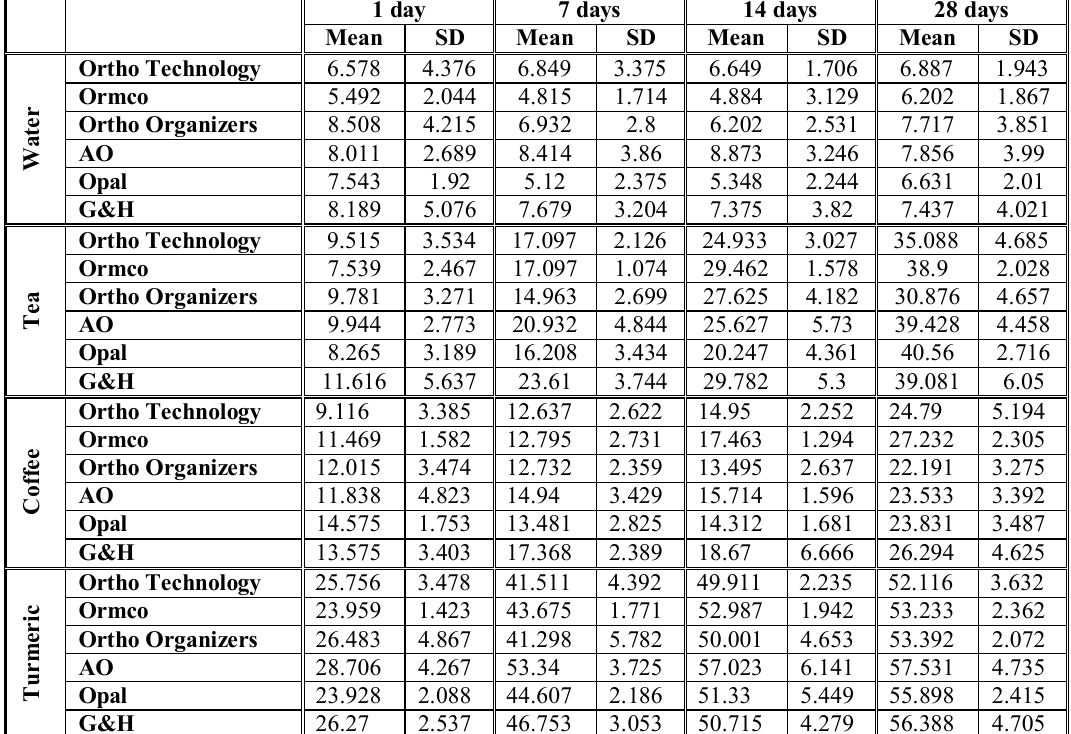
Table 1: Mean and standard deviation of the color changes (∆ E* ab) of all brands after immersion in the dietary